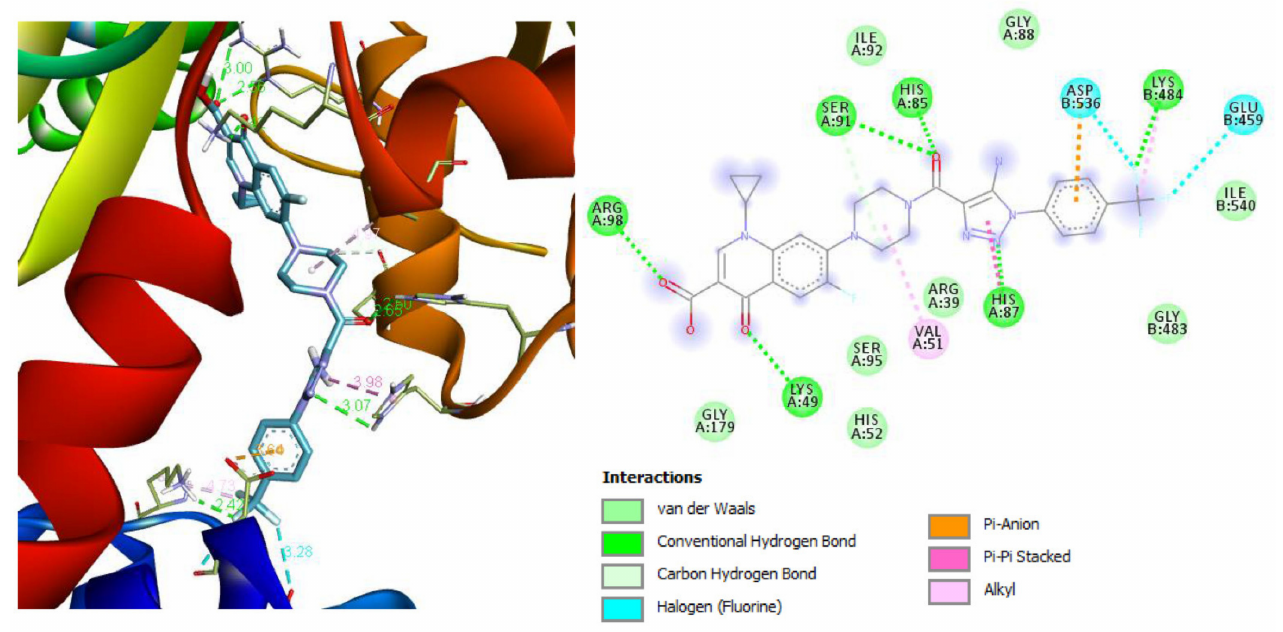
Figure 6. Superposition of molecule 2l and diagram of intermolecular interactions in complex with